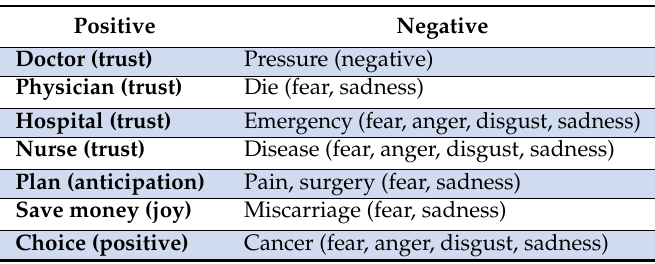
Table 1. Positive and negative emotions expressed on Twitter, by the words used in the